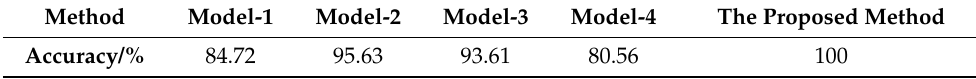
Table 7. Test result of reversed